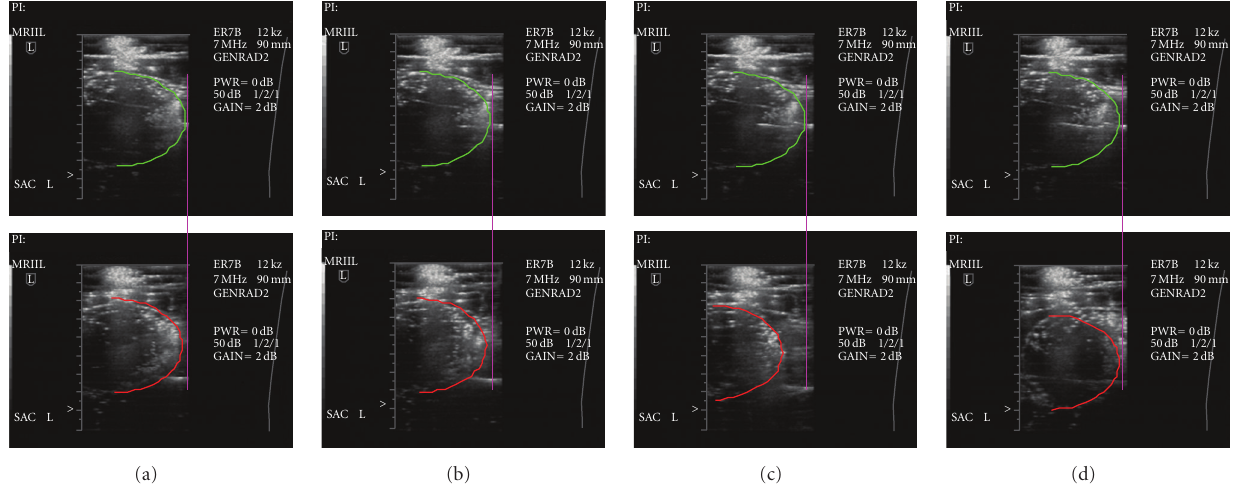
Figure 11: Tissue displacements for the MPC (green) and for open-loop control approach (red). Disturbance d is given to MPC and its e ff ect is predicted and compensated before e ff ect appears at the system